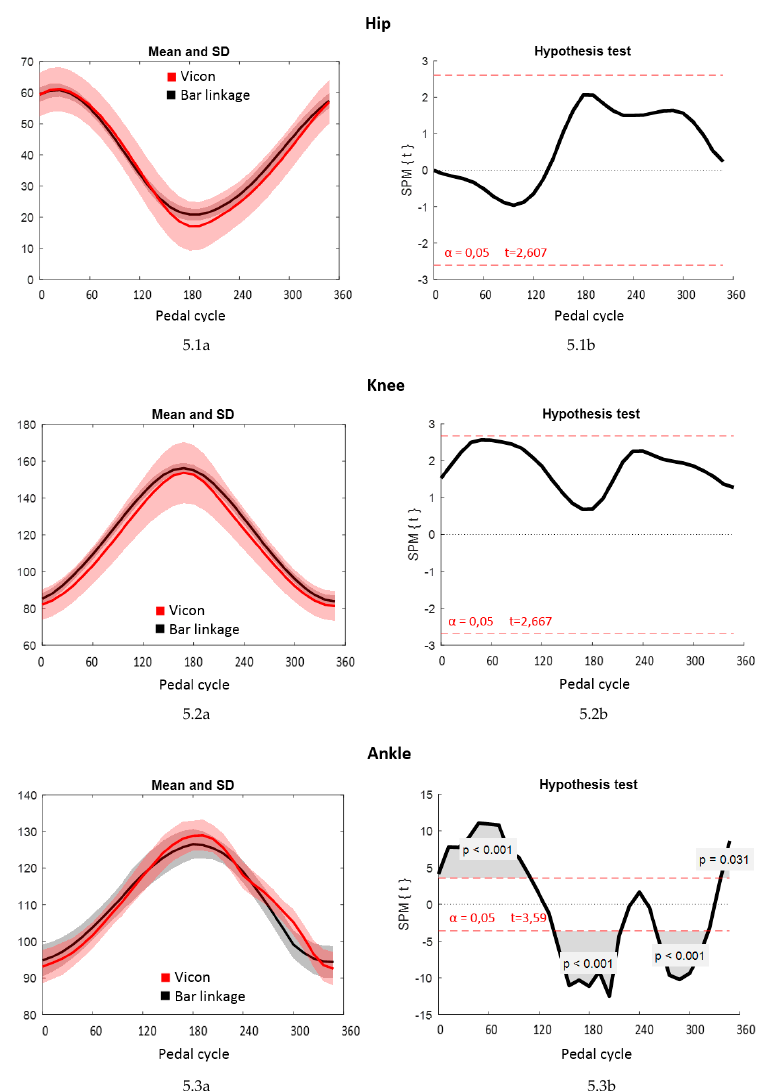
Figure 5. From top to bottom: SPM1D output of the method-specific AVCs from the hip (5.1); knee (5.2) and ankle (5.3). From left to right: Mean and standard deviation of the motion capture system and the bar linkage ( a ); plot of the p -values ( b ).